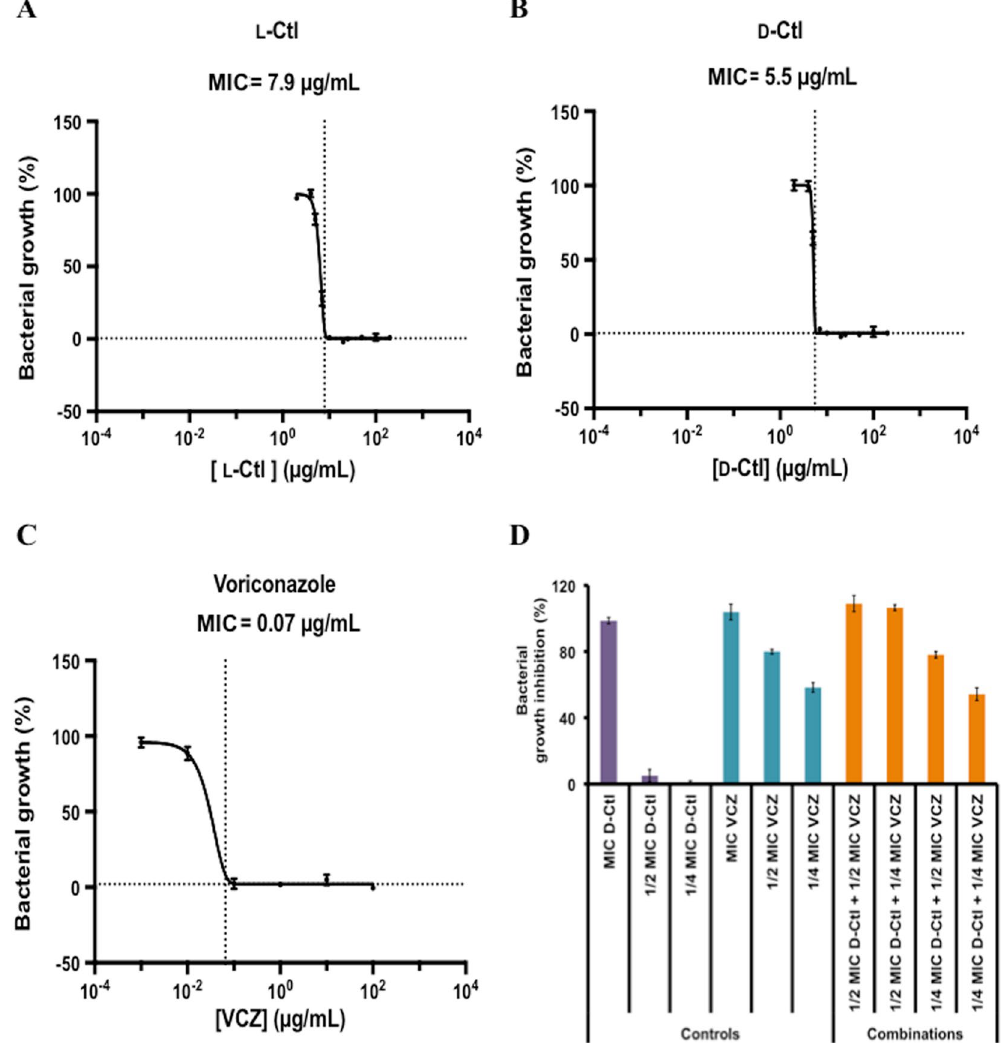
Figure 1. Antifungal activity of L-Ctl, D-Ctl, voriconazole (VCZ) and the combination of D-Ctl and VCZ against Candida albicans . Antifungal tests were performed in the presence of L-Ctl ( A ), D-Ctl ( B ), VCZ ( C ) or D-Ctl in combination with VCZ ( D ) as indicated. For each figure, the average of at least three separate experiments is shown. Each MIC, defined as the lowest concentration of antifungal agent (alone or in combination) able to inhibit 100% of C. albicans growth, was determined using a modified Gompertz